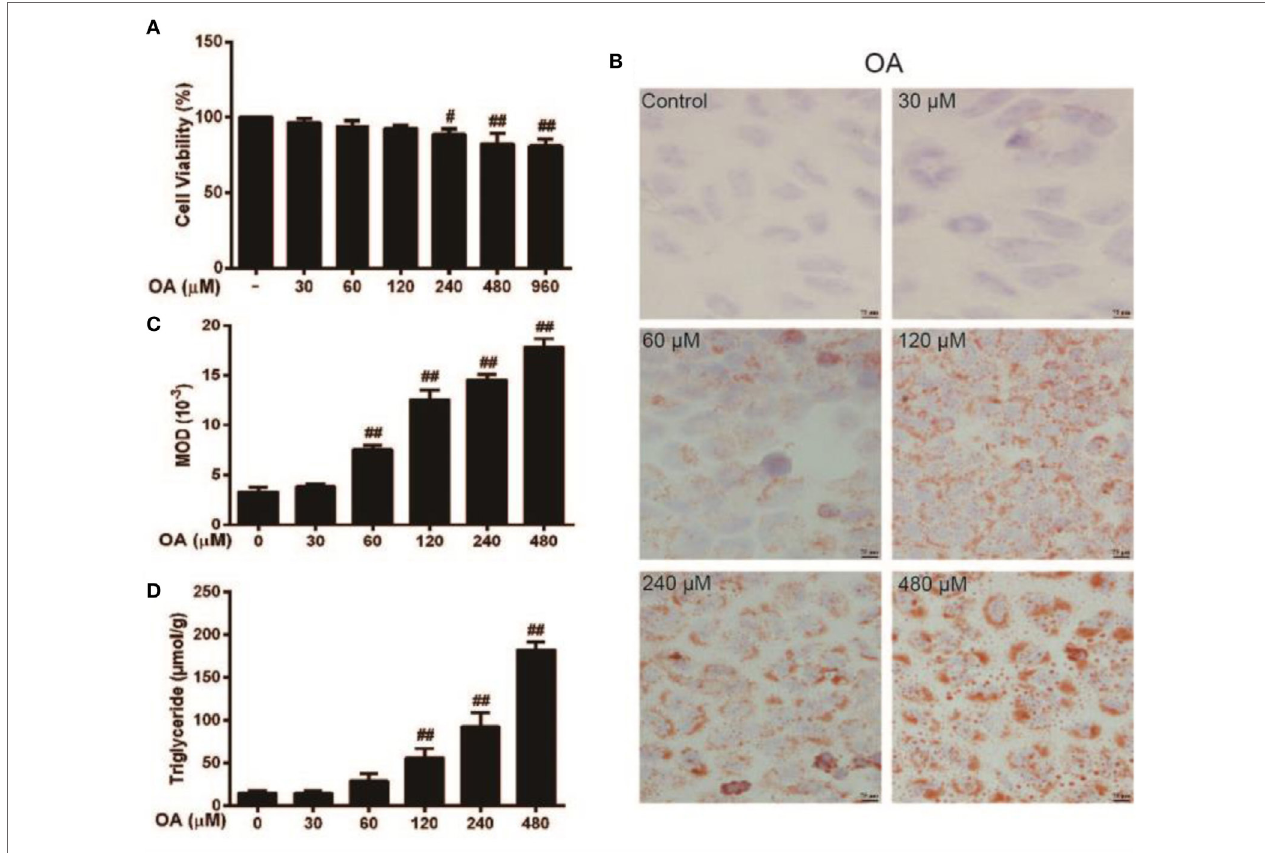
FigUre 1 | Effect of oleic acid (OA)-induced triglyceride (TG) accumulation and cytotoxicity in HepG2 cells. (a) HepG2 cells were exposed to various concentrations of OA (0, 30, 60, 120, 240, 480, and 960 µM) for 24 h, and cell viability was subsequently determined by MTT assay. (B,c) The effect of OA (30, 60, 120, 240, and 480 µM) on TG accumulation in HepG2 cells. Original magnification was 200 × , and scale bars represent 75 µm. (D) Effect of TG concentration on OA-induced HepG2 cells. All data are expressed as the mean ± SD of three independent experiments. Statistically significant at # p < 0.05 and ## p < 0.01 vs. the control group (one-way ANOVA followed by Tukey’s